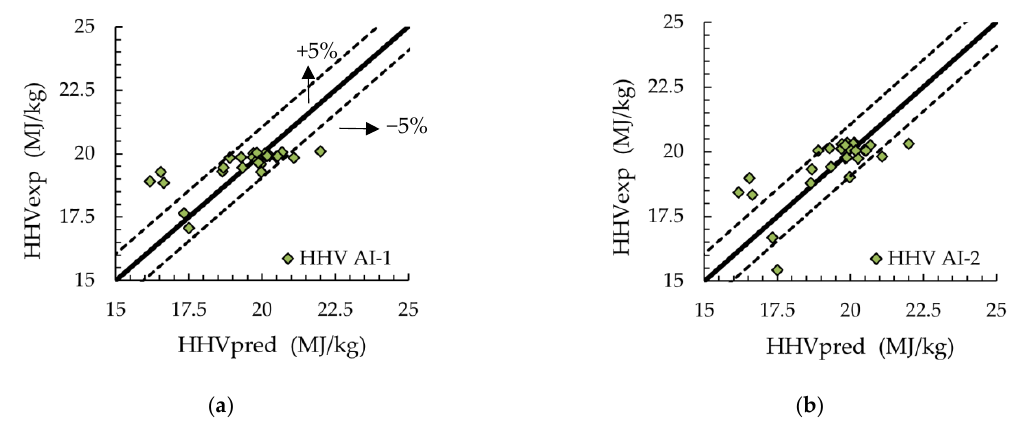
Figure 7. Comparison of the experimental and predicted values for HHVs with the different proposed equations using proximate analysis parameters: ( a ) AI-1; ( b ) AI-2.